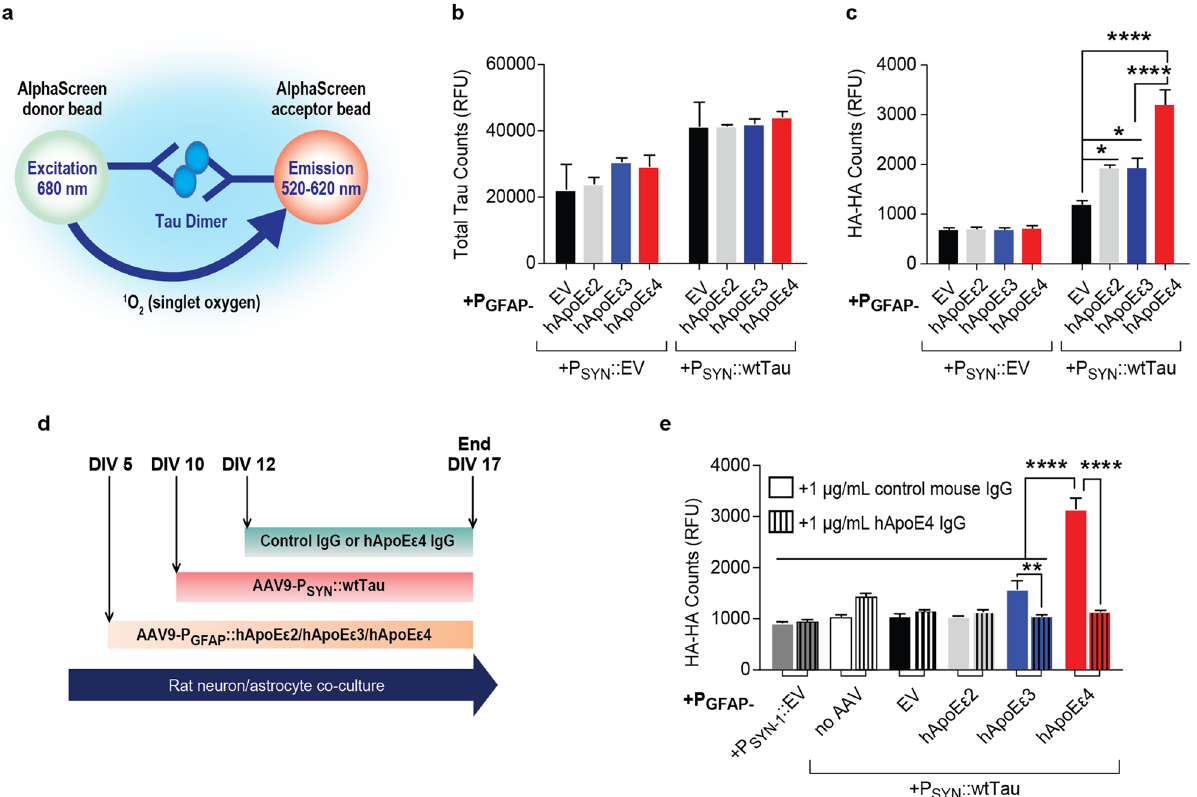
Figure 3. hApoEε4 increases the oligomerization of neuronal tau. Quantification represents data from one independent experiment. (a) Schematic to illustrate the AlphaLISA principle for detecting the oligomerization of HA-tagged tau constructs using HA-HA AlphaLISA. Image was created using Adobe Illustrator CC2018 v.22.0.0 (https ://www.adobe .com/Adobe /Illus trato r). (b) AlphaLISA results to quantify the abundance of total (rat + human) tau in co-cultures 7 days after transduction with tau (DIV17) ( n = 3 sample means/group). (c) Results of HA-HA AlphaLISA seven days after transduction with tau (DIV17) ( n = 7 sample means/group). * p < 0.05, **** p < 0.001, Tukey’s multiple comparisons test following one-way ANOVA. (d) Experimental paradigm to treat AAV-P GFAP ::hApoE + AAV-P SYN ::wtTau co-cultures with relevant IgG’s. Schematic was created using Microsoft Word v2002 (https ://www.micro soft.com/en-us/micro soft-365/word). (e) Results of HA-HA AlphaLISA seven days after transduction with HA-tagged tau following treatment with 1 μg/mL control or hApoEε4-specific antibodies as described in panel (b) ( n = 3 sample means/group). ** p < 0.01, **** p <